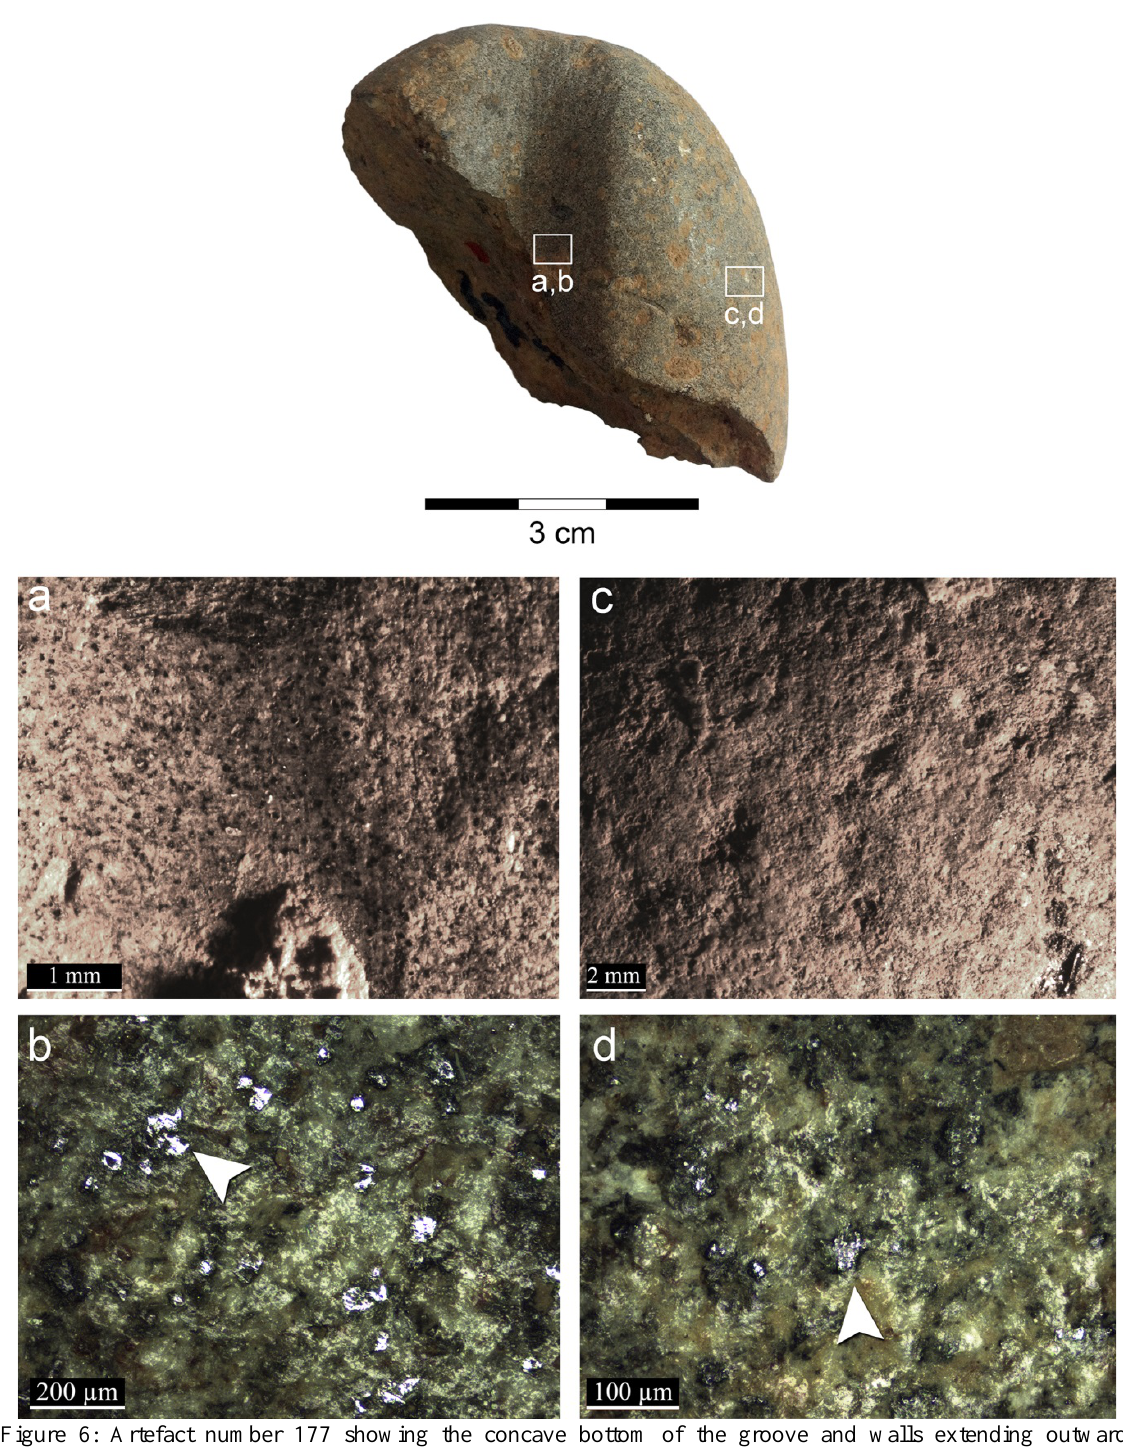
Figure 6: Artefact number 177 showing the concave bottom of the groove and walls extending outward. Locations of microphotographs are indicated by arrows. Traces inside the groove interpreted as having been produced by contact with a medium hardness material such as bone, wood or reeds: a) extremely flattened surface at the bottom area of the groove associated with shallow grooves on the sides extending parallel to the axis of the groove and indicating the direction of abrasion (x20), b) translucent thin polish on groundmass associated with patches of thick, bright, smooth polish indicated by the white arrow that developed on phenocrysts exhibiting directionality pattern along the axis of the groove (x100) (similar polish was observed on artefact number 176, see Figure 5b at higher magnification). Traces on the perimeters interpreted as having been produced by contact with a hard stone: c) wide flat peaks associated with small lower surfaces indicating a more intense abrasion (original magnification x6.7), d) rough bright polish developed on protruding points indicated by the white arrows showing no directionality patterns